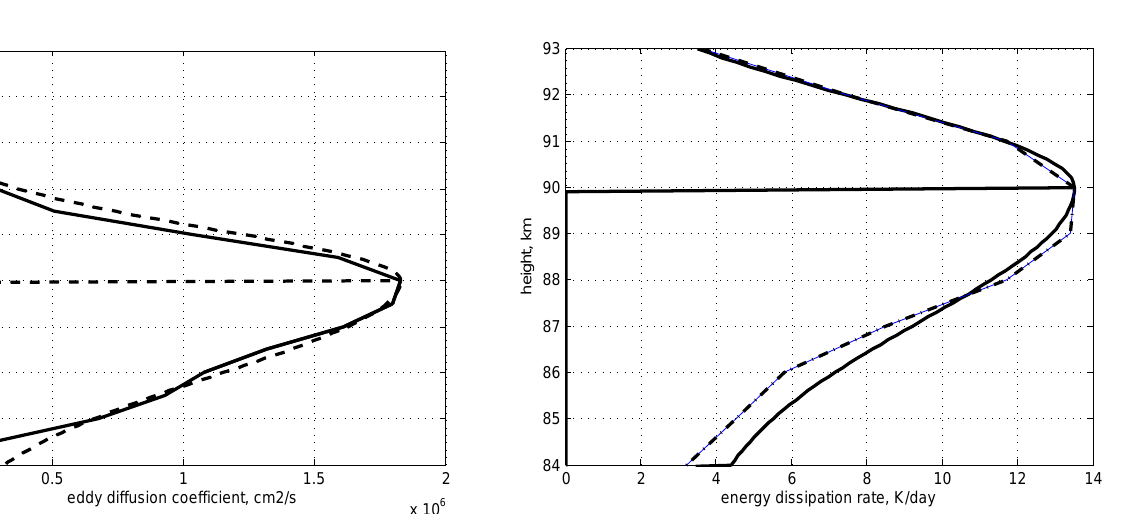
Figure A1. The eddy diffusion coefficient inferred by Lübken (1997) in polar summer (solid curve) and approximated by Eqs. (A1) and (A2) (dashed curve).